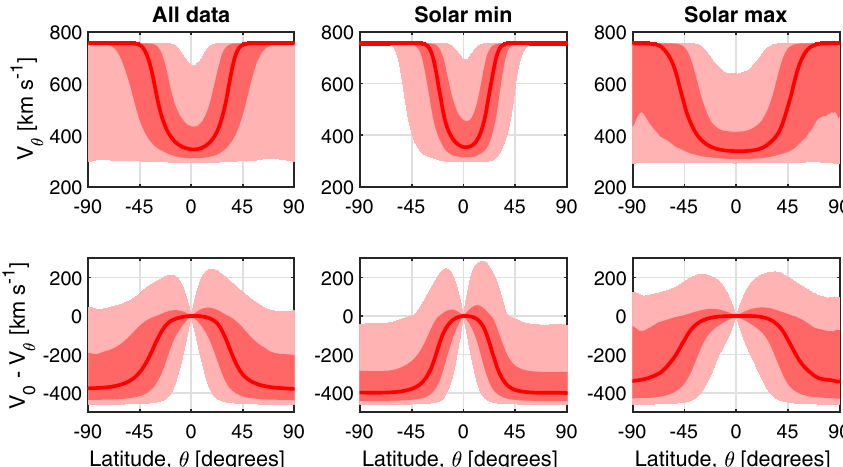
Fig. 2. Top: the distributions of V h , the solar wind speed at 1 AU, as a function of heliographic latitude, h , for 40+ years of model results. The red line shows the median, the dark-pink shaded region spans the 25 – 75 percentiles of the distribution (i.e., the inter-quartile range), while the light-pink regions spans 5 – 95 percentiles of the V h distribution. Panels, from left to right, show the whole dataset, solar minimum, and solar maximum periods, respectively. Bottom: the distributions of the difference in solar wind speed at a given latitude to that at the equator, i.e. V 0 (cid:3) V h , as a function of h . In the same format as the top